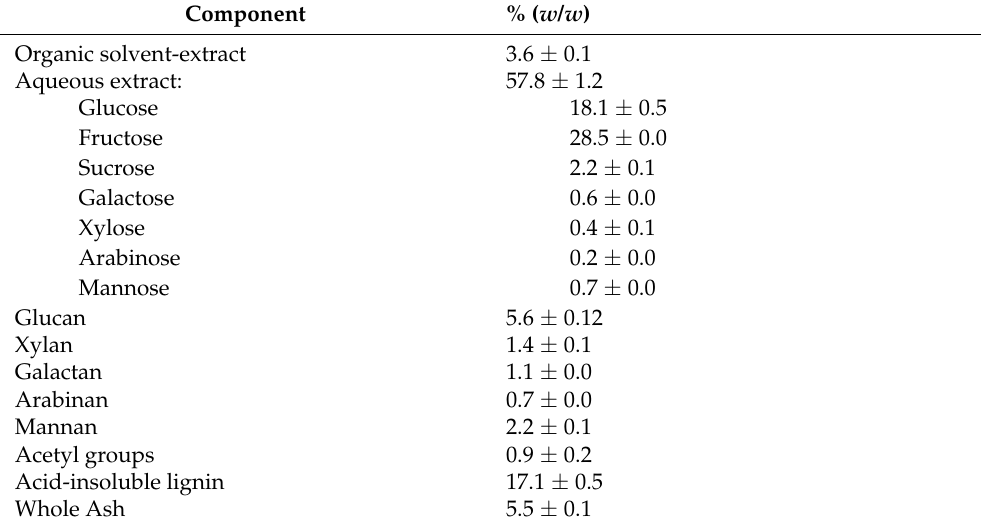
Table 3. Discarded pepper waste (DPW) composition. Data expressed as percentage ( w / w ) on dry weight (DW) basis.